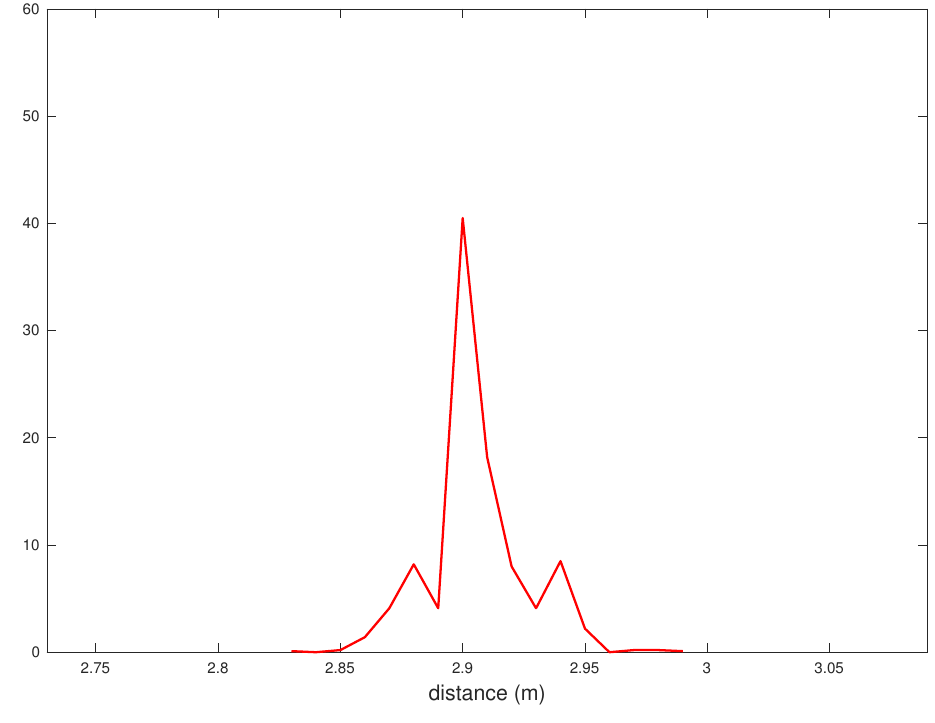
Figure 3. The PDF of range measurements for r = 3